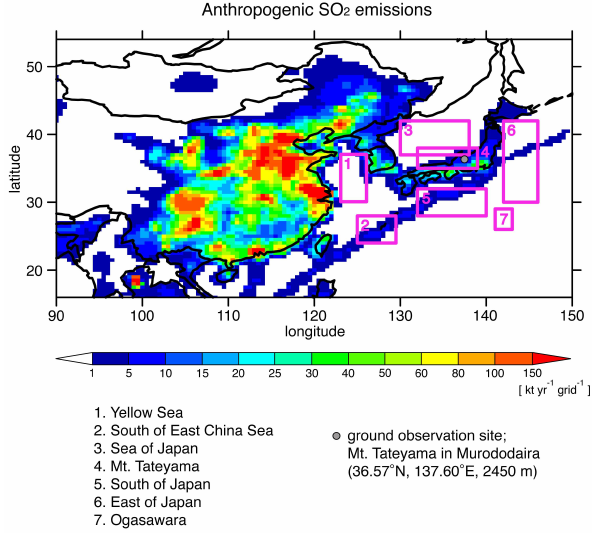
Fig. 1. Anthropogenic SO 2 emissions over East Asia in 2005 based on the REAS emission inventory. Numbered rectangles indicate the regions used in Fig. 3, and the closed gray circle in region 4 indicates the location of Mt.